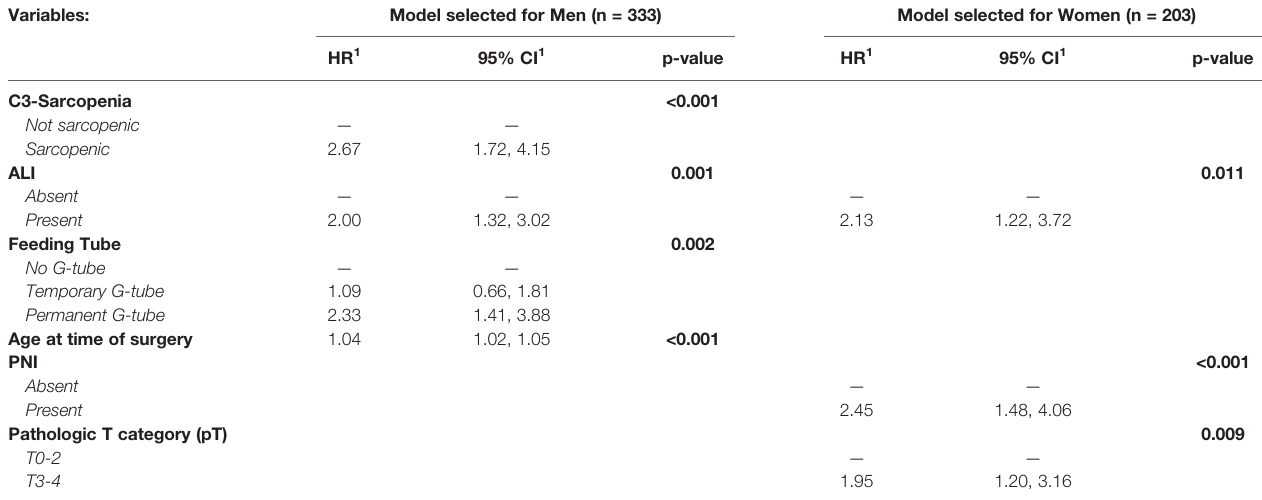
TABLE 2 | Multivariable model for factors associated with risk of death with head and neck cancers in validation cohort, by sex (n = 536).